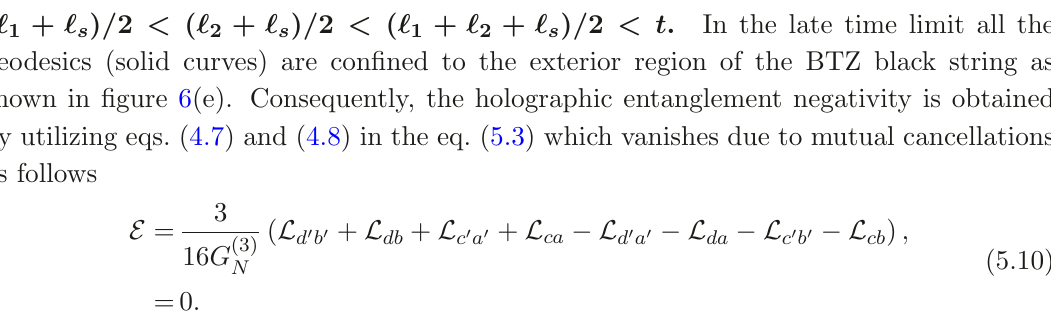
Figure 6 . Geodesic configurations for differnt limits of the time relative to the lengths of the intervals. The geodesics depicted by dashed lines pass through the interior region of the BTZ black string connecting the two Rindler wedges I and III . The geodesics depicted by solid lines are confined to the exterior region of the BTZ black string outside the